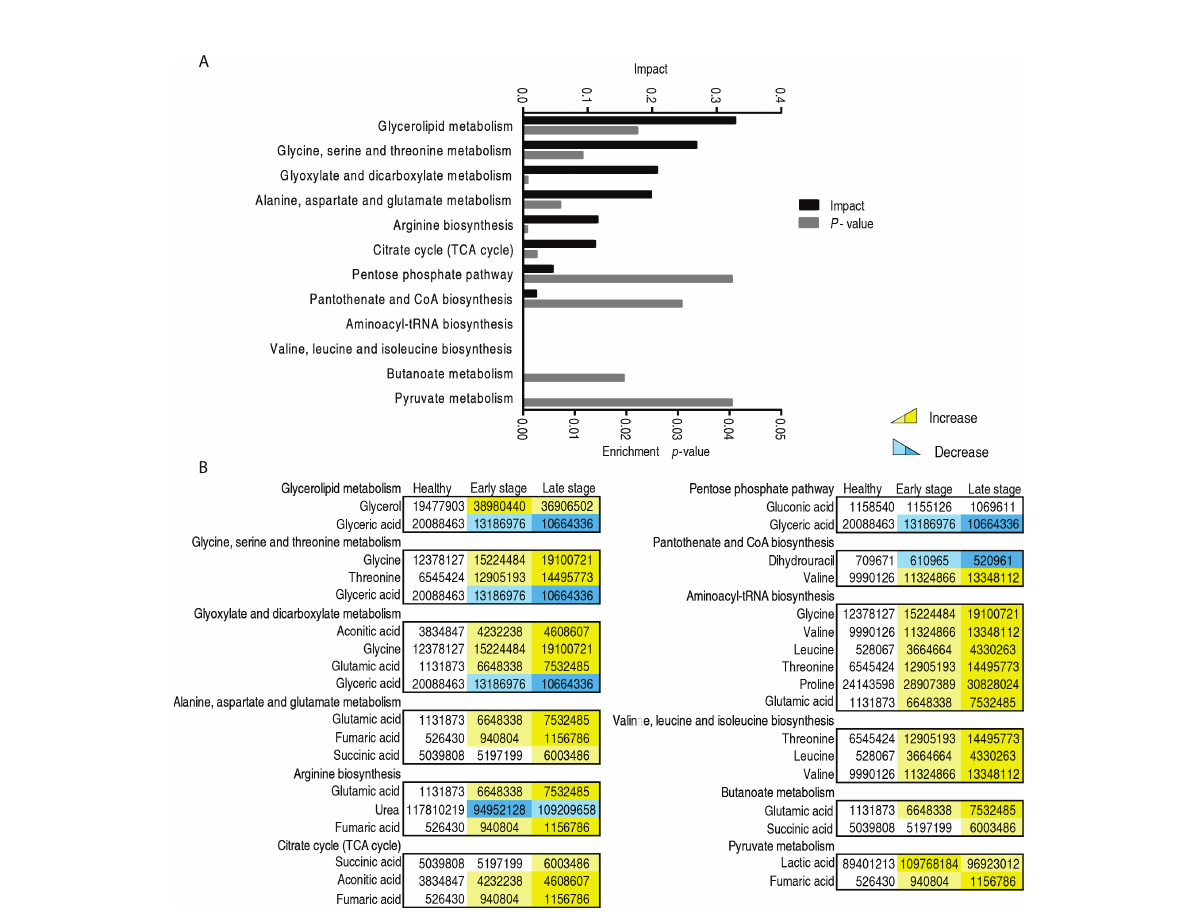
FIGURE 6 Pathway enrichment in the early and late -stages of patients with esophageal cancer. (A) Pathway enrichment of differential abundant metabolites. (B) The level of the differential metabolites of stage 0 – II and stage III – IV esophageal cancer compared with healthy people. Yellow and blue indicate increase and decrease of metabolites,